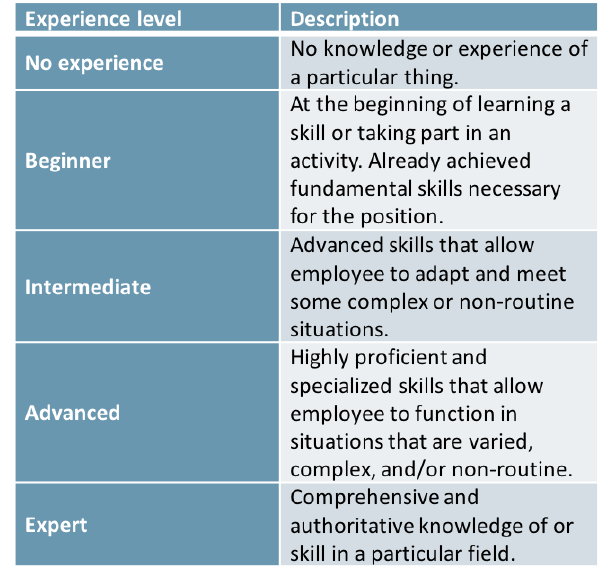
Table 11: Amount of diflculty related to working